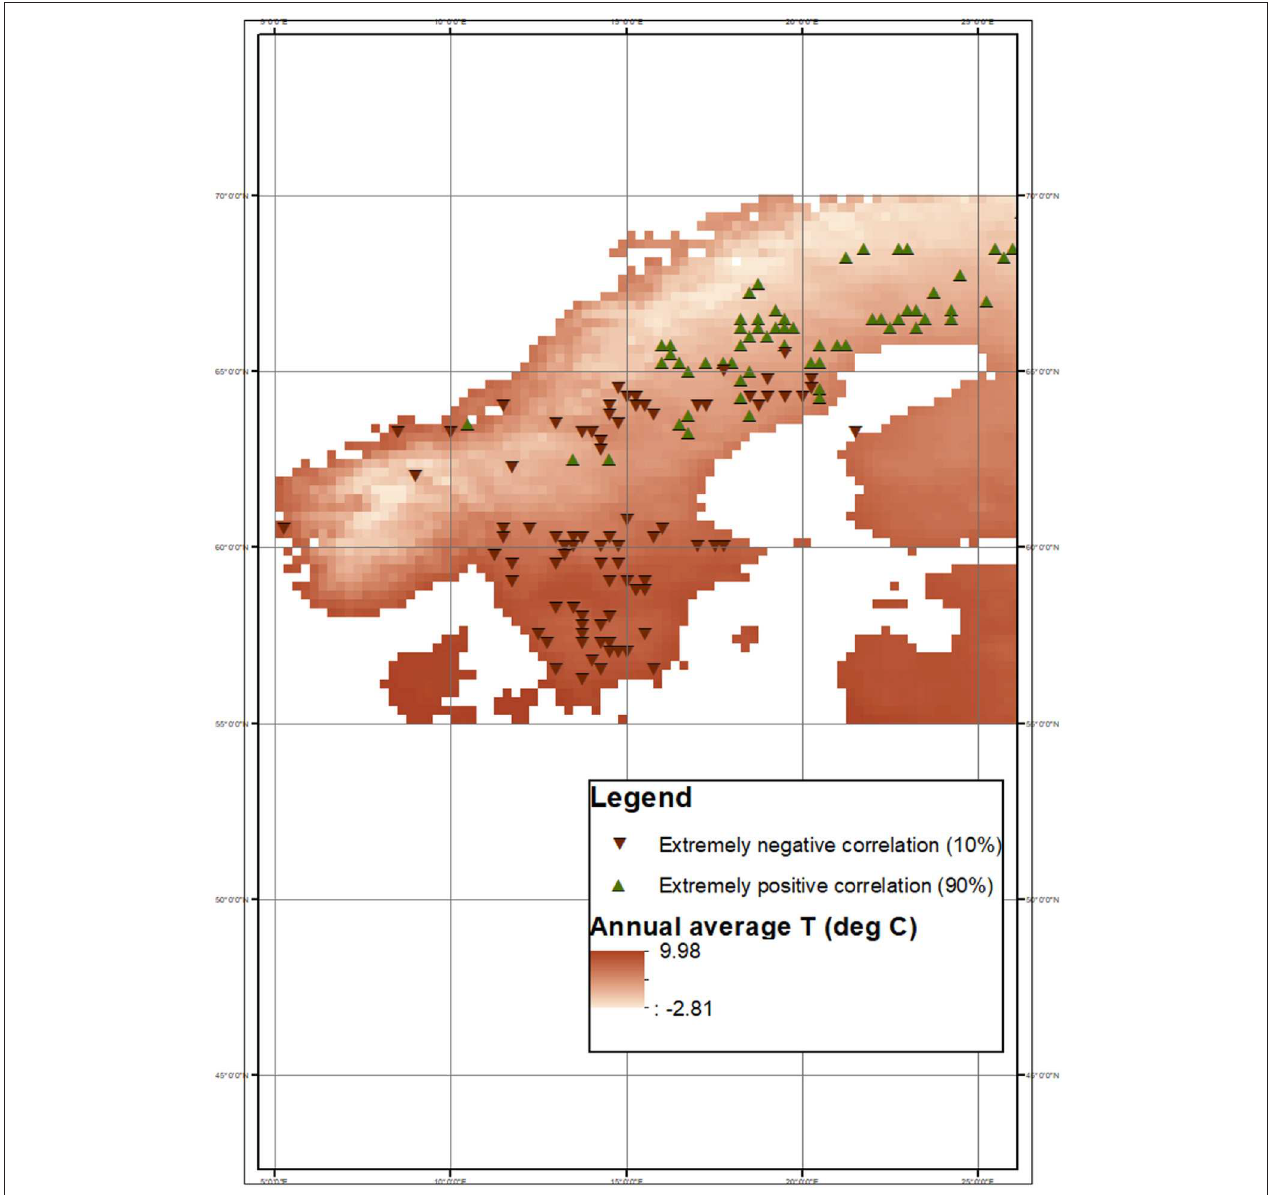
FIGURE 4 | Pixels where extremely positive (90th percentile) and negative (10th percentile) correlation between NDVI GS and T MAX − GS occur. The annual average T A map was obtained from E-OBS gridded